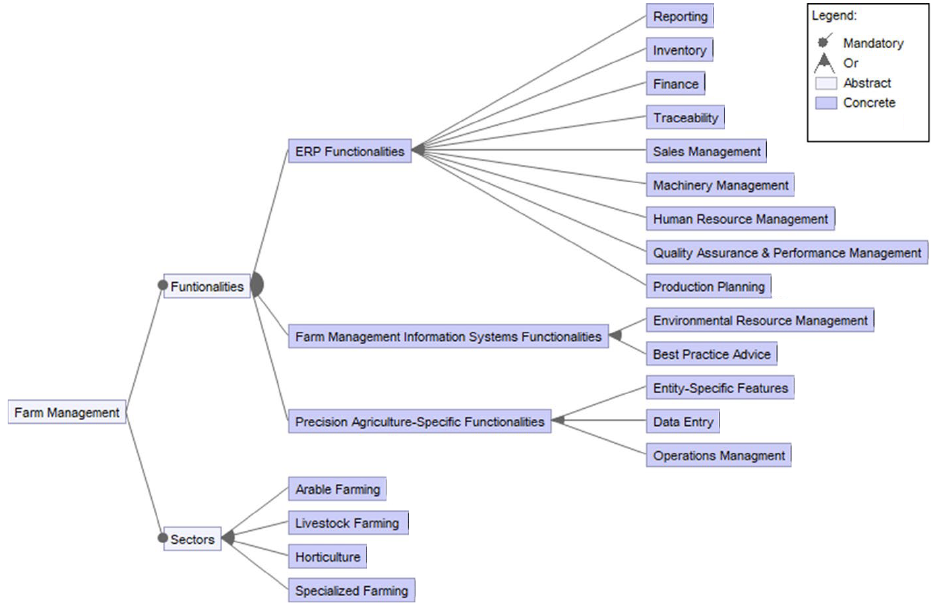
Figure 11. A feature model for precision agriculture farm management